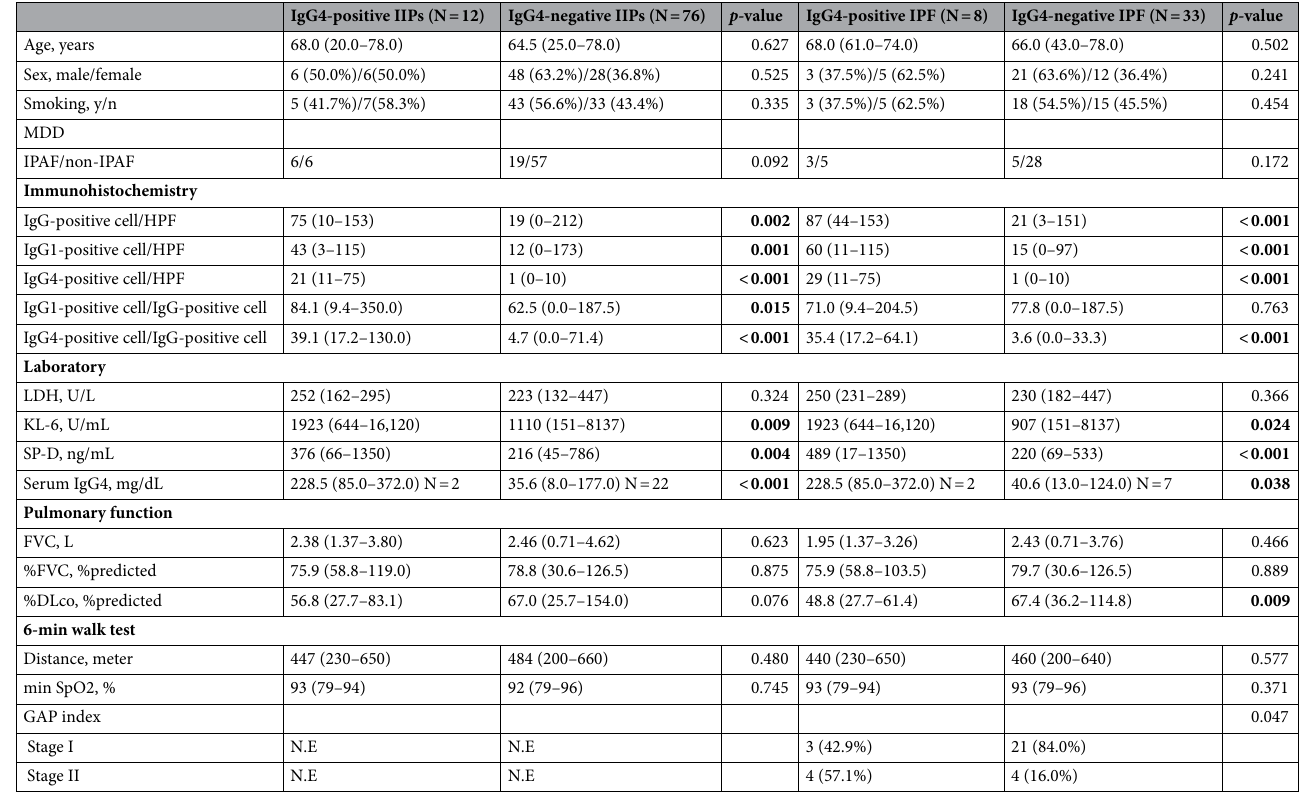
for carbon monoxide, FVC forced vital capacity, HPF high-power field, Ig immunoglobulin, IIP idiopathic interstitial pneumonia, IPAF interstitial pneumonia with autoimmune features, IPF idiopathic pulmonary fibrosis, KL-6 Krebs von Lungen-6, LDH lactate dehydrogenase, MDD multidisciplinary discussion, SP surfactant protein, y/n